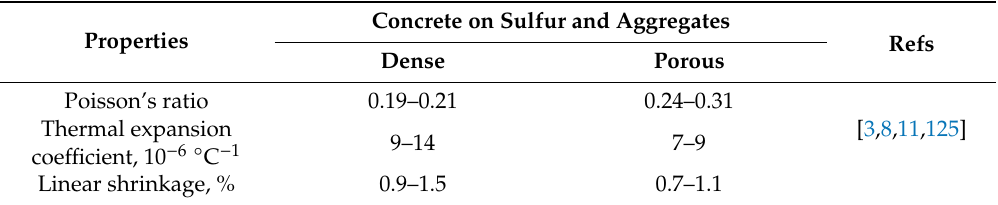
Table 8. Deformative properties of sulfur-based concretes.